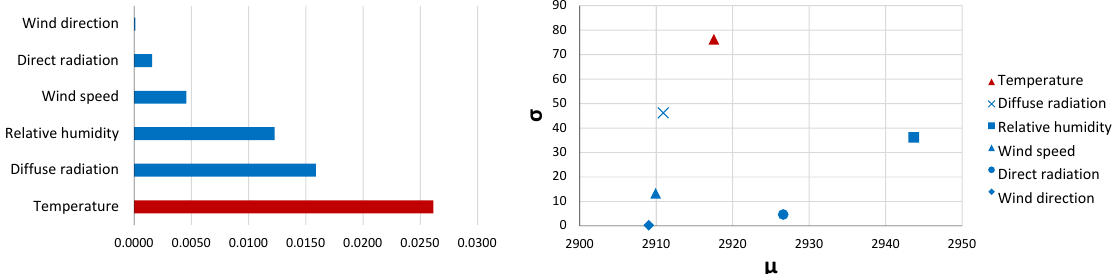
Figure 7. ( left ) “Relative deviation” method; ( right ): Morris method